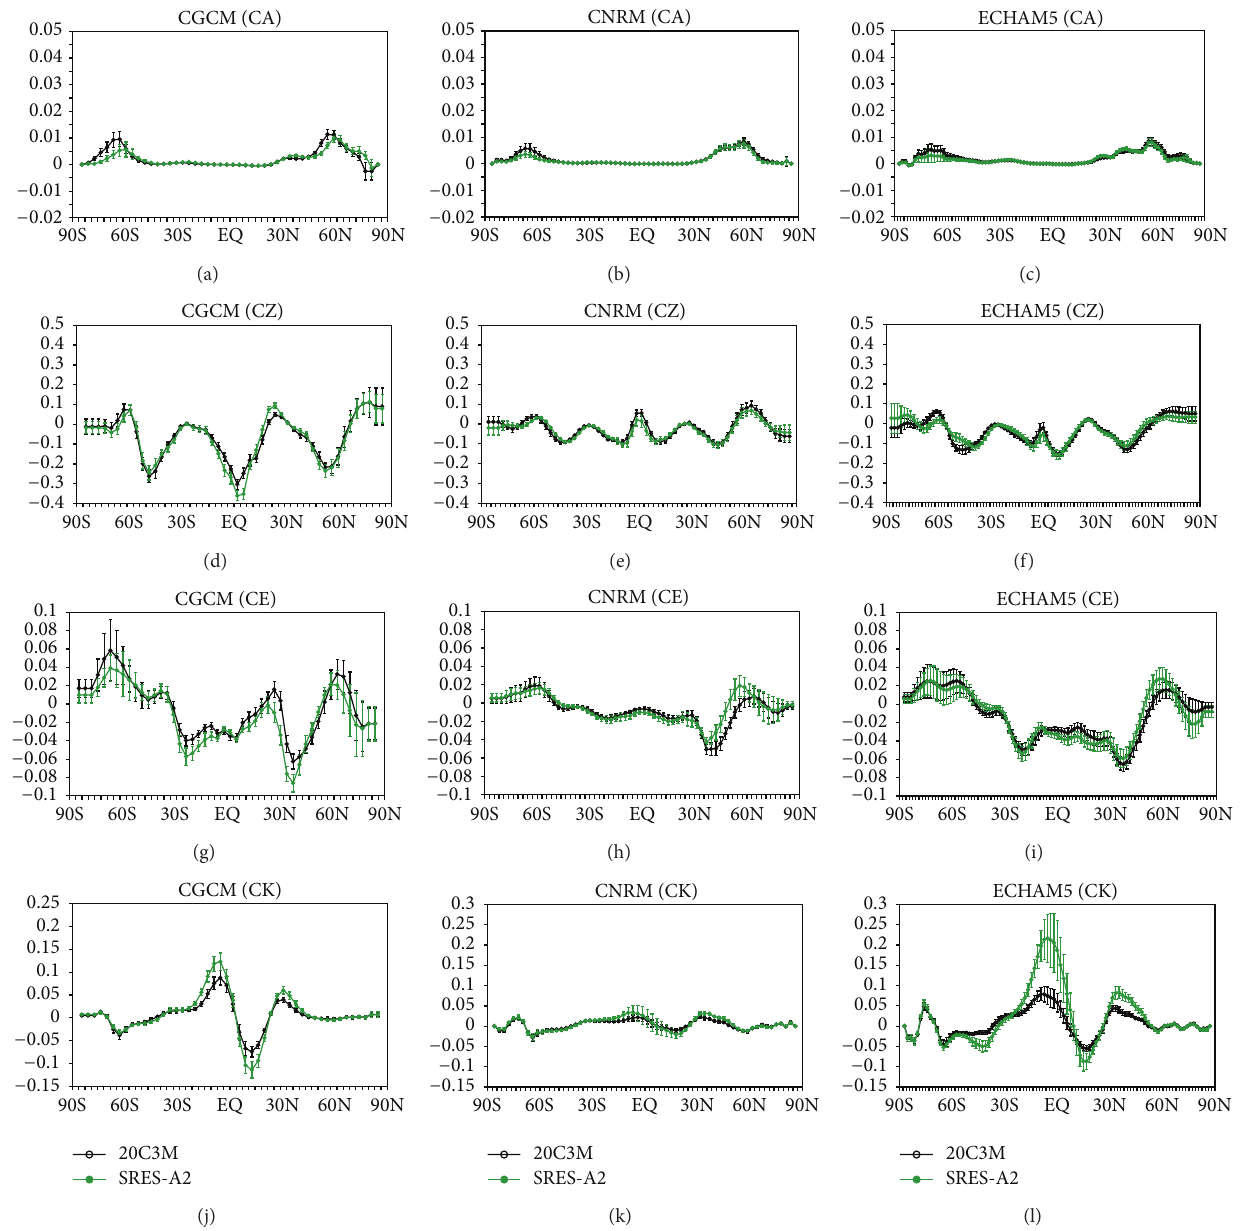
Figure 7: Latitudinal distribution of volume integrated of CA for CGCM (a), CNRM (b), and ECHAM5 (c), CZ for CGCM (d), CNRM (e), and ECHAM5 (f), CE for CGCM (g), CNRM (h), and ECHAM5 (i), and CK for CGCM (j), CNRM (k), and ECHAM5 (l) models. Error bars indicate 95% confidence intervals about the mean. Units are Wm −2